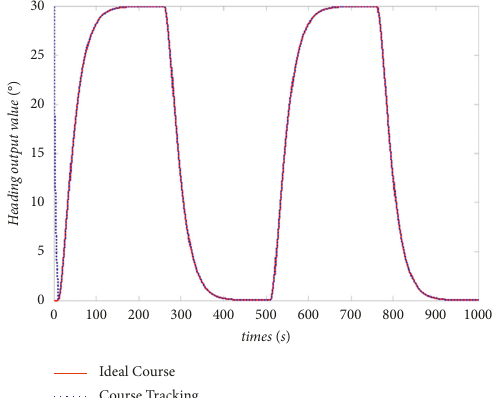
Figure 3: The results of heading output in the experiment.